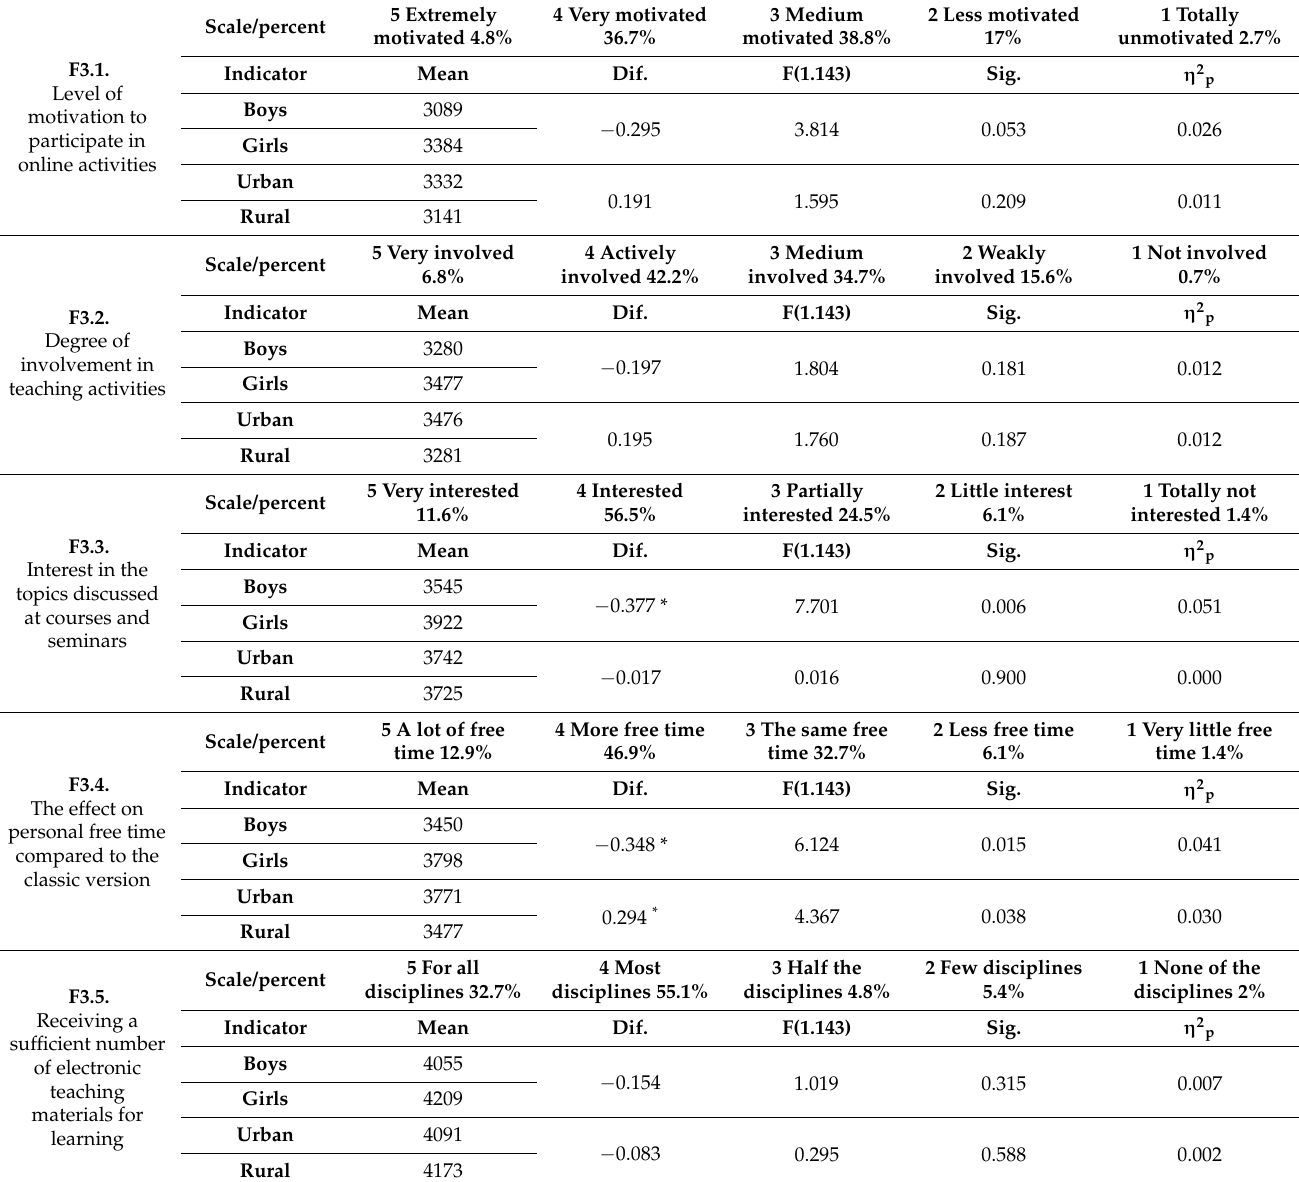
Table 8. The results of the questionnaire for the motivation factor (univariate test).